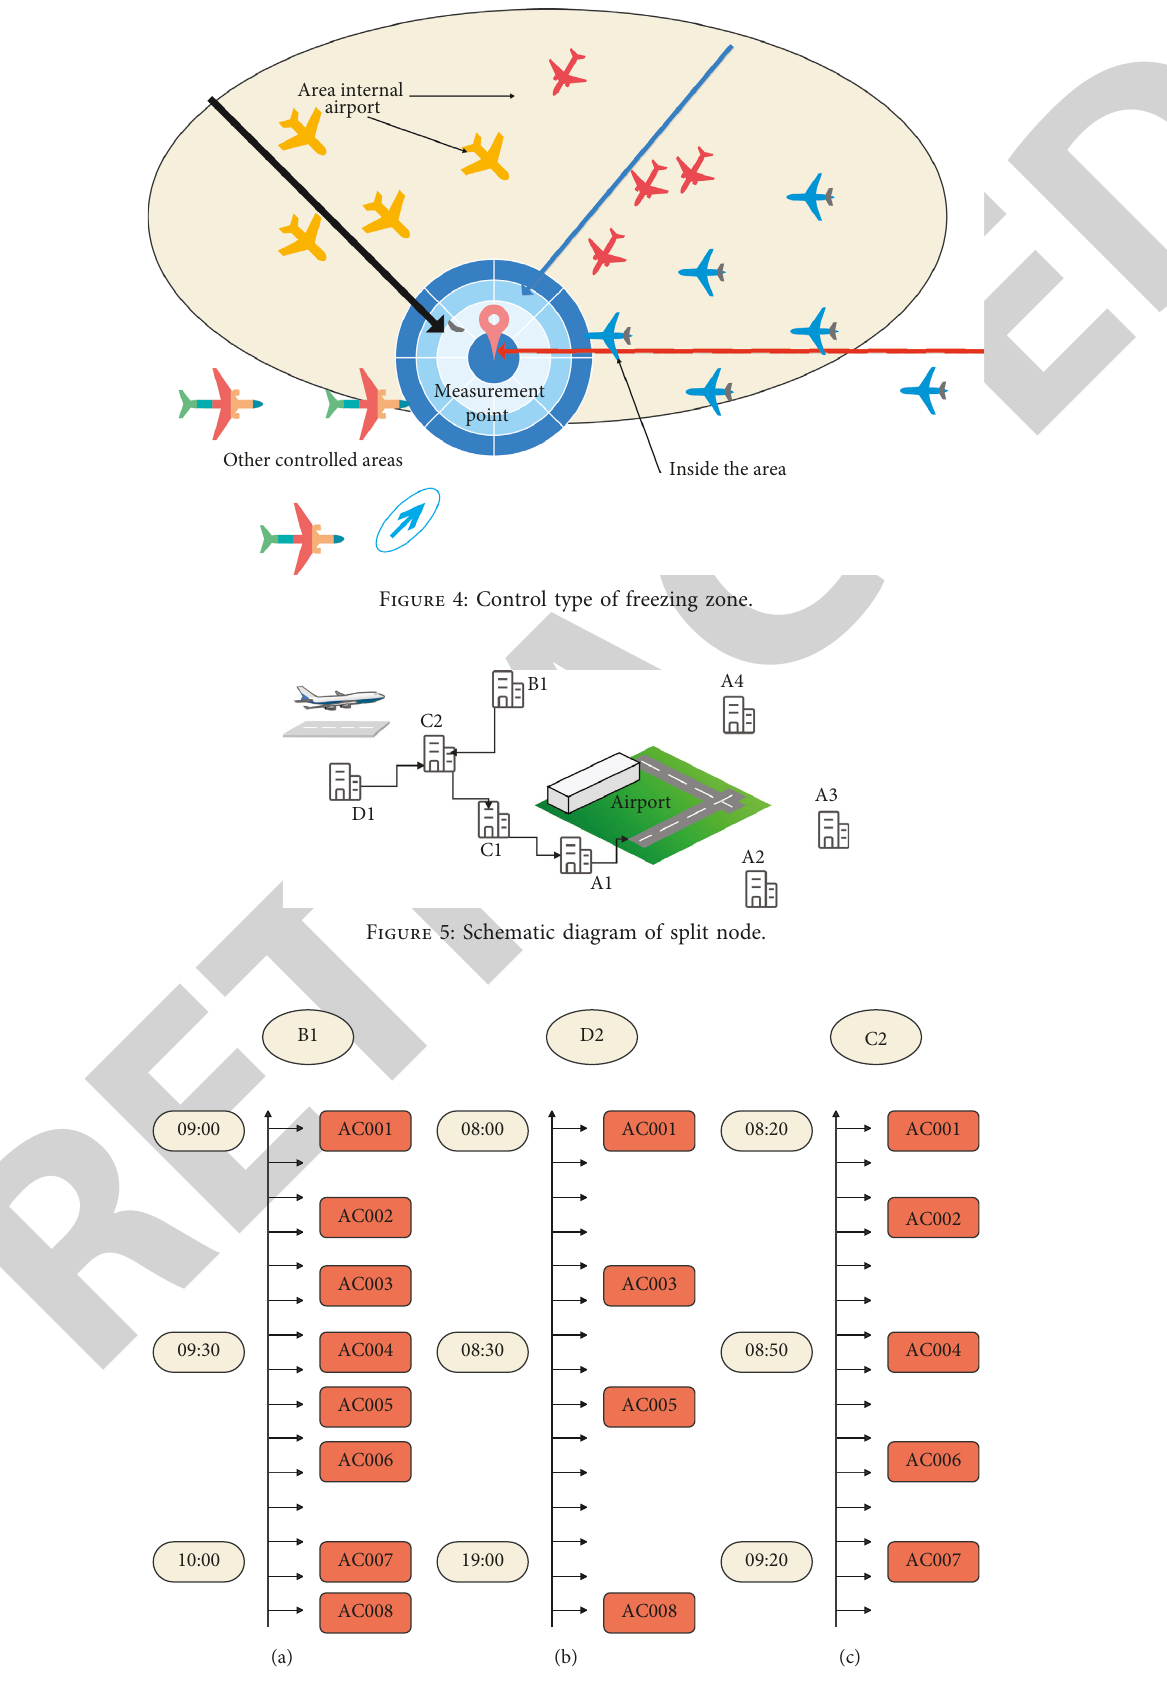
Figure 6: Split time distribution